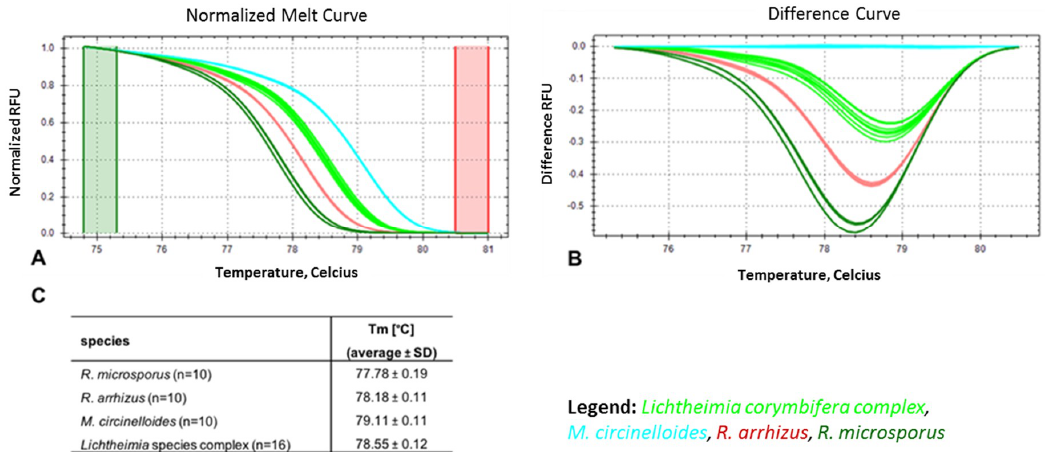
Figure 3. Melt curves: ( A ) high resolution melt curve, ( B ) melt difference curve (Tm) with respective standard deviation (SD), and ( C ) melt temperatures obtained for DNA eluates of R. microsporus , R. arrhizus , M. circinelloides , and Lichtheimia spp. pure cultures using rnl real time PCR-HRM. Analysis of the rnl real-time PCR-HRM confirmed pan- Mucorales species specificity. Preliminary in silico screens identified overlaps with 11 other mucoralean sequences deposited in the NCBI variety of mucormycetes could be detected using rnl real-time PCR-HRM. Among the species tested were: C. bertholletiae , M. racemosus , P. blakesleeanus , R. pusillus , and S. racemosum . All species gave distinctly different melt peaks and melt profiles. Unspecific clustering among the four target species was not observed (Figure S1A–C).